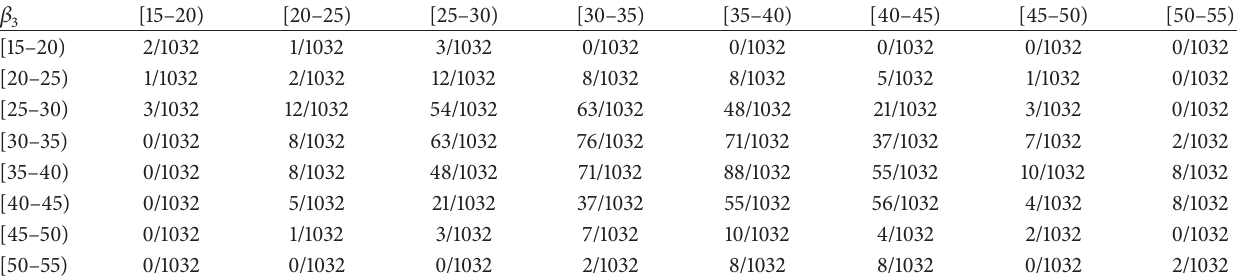
Table 8: AgeBinned bivariate 𝛽 3 .